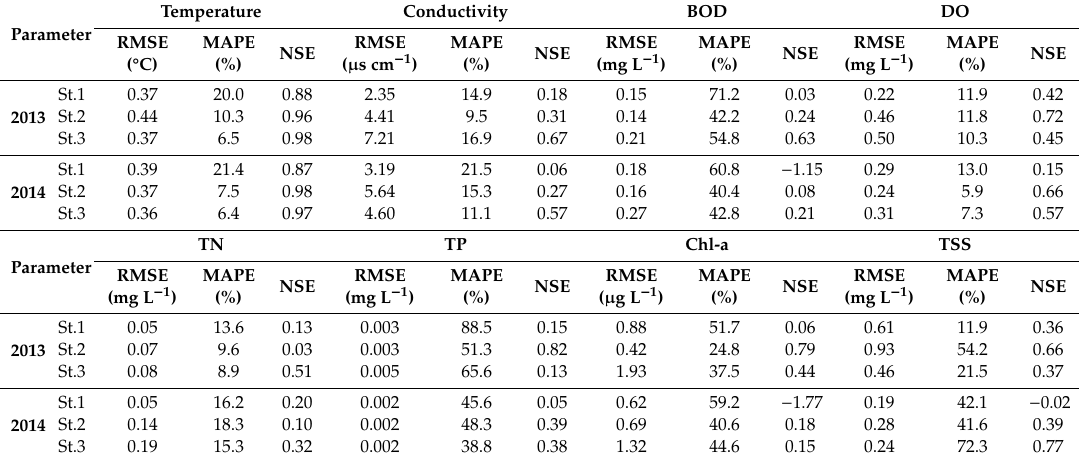
Table 2. Calibration and verification statistics of temperature, conductivity, and water quality model.